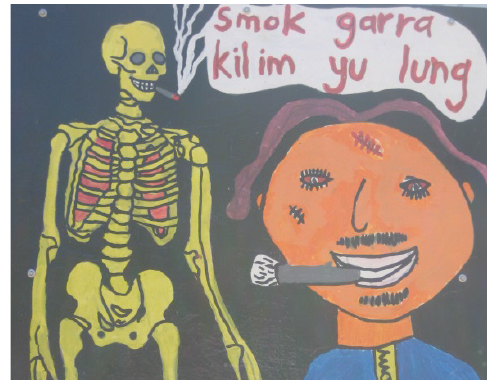
Figure 4. Mural at remote community